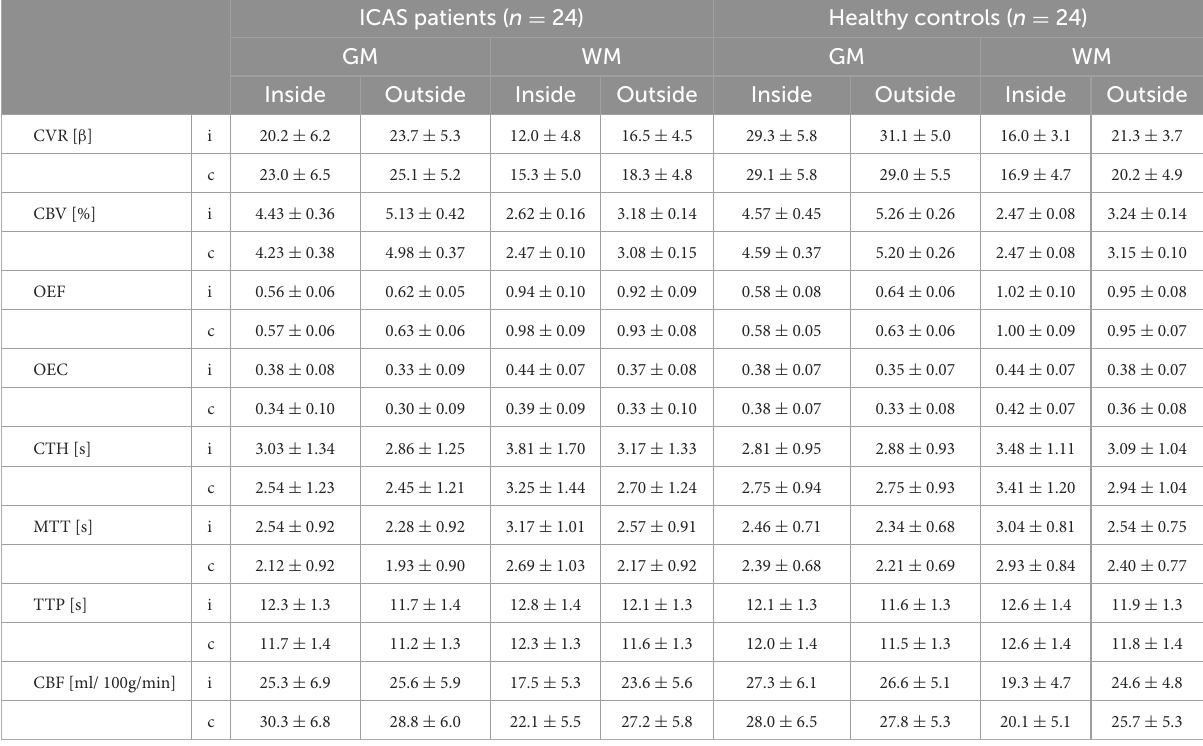
TABLE 1 Group average parameter values for ICAS patients and healthy controls for all evaluated